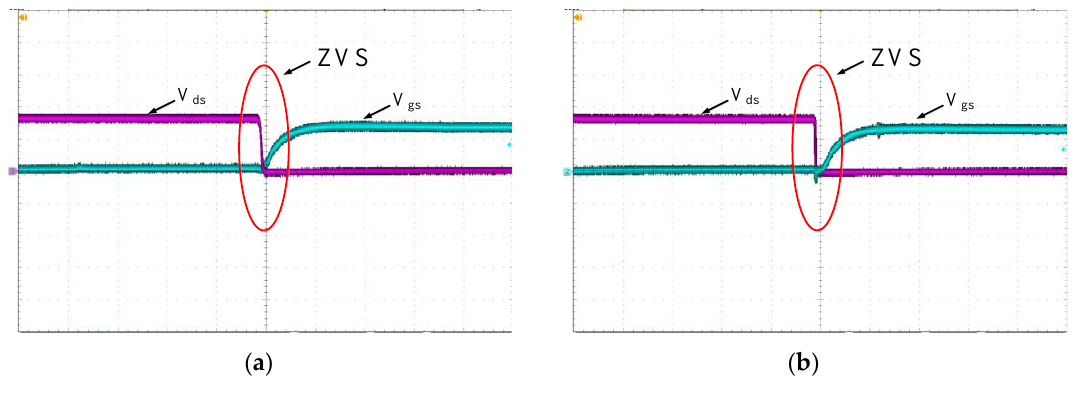
Figure 19. Measured ZVS waveforms under different load conditions. ( a ) 50 W; ( b ) 300 W. (CH1: 10 V/div, CH2: 100 V/div, Time: 800 ns/div)